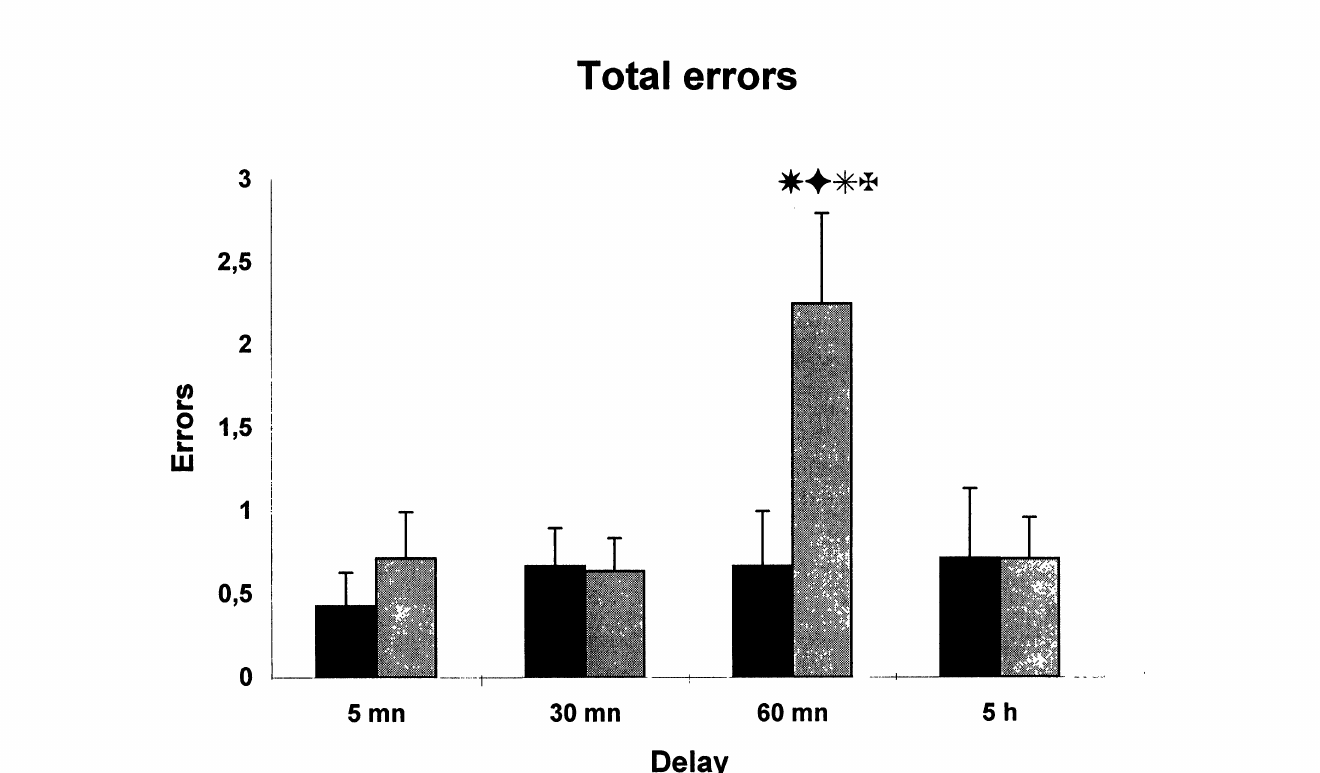
Fig. 1: Total number of errors (mean + s.e.m.). B: control. V1 timolol. Rats were injected with timolol 60 min. after the reactivation trial made significantly more errors than those of all other groups. p<.05 compared with saline-injected group at the same delay; / p<.01 compared with timolol-injected group at the delay 5 min.; p<.01 compared with , p<.01 compared with timolol-injected group at the delay 5 timolol injected group at the delay 30 min.;